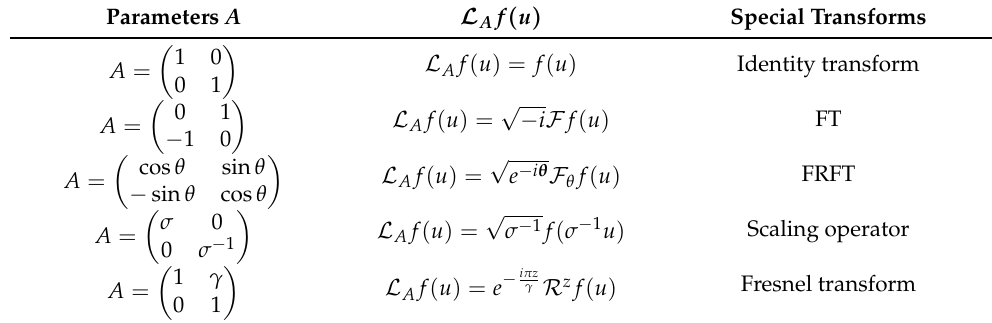
Table 1. Special cases of